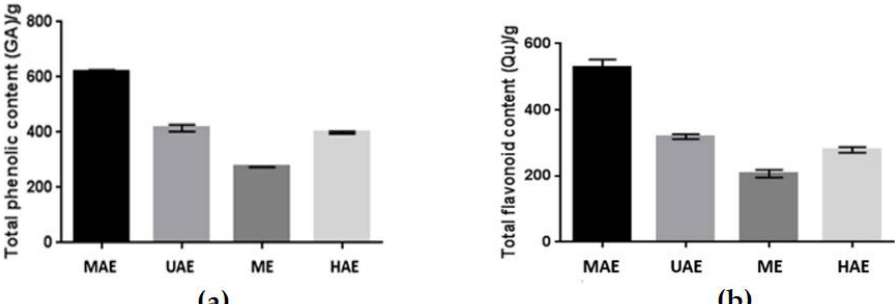
Figure 1. Total phenolic content ( a ) and total flavonoid content ( b ) in four types of aqueous extracts (UAE-ultrasound-assisted extraction; MAE–microwave-assisted extraction; ME–maceration with continuous stirring; HAE–heat-assisted extraction) of Schisandra chinensis fruits. Values are the mean of six replicate determinations ( n = 6) ± SD. Table 1. MS data of polyphenolic components identified in S. chinensis fruits extract at negative ionization